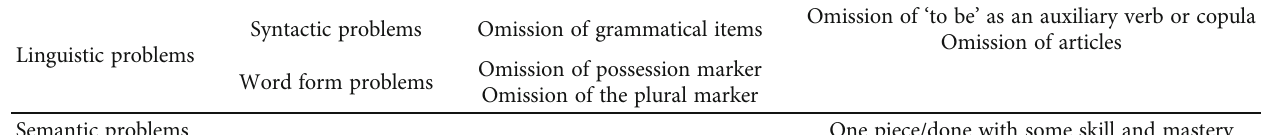
Table 5: Linguistic and semantic problems of English translation of the main prayer hall building brochure.